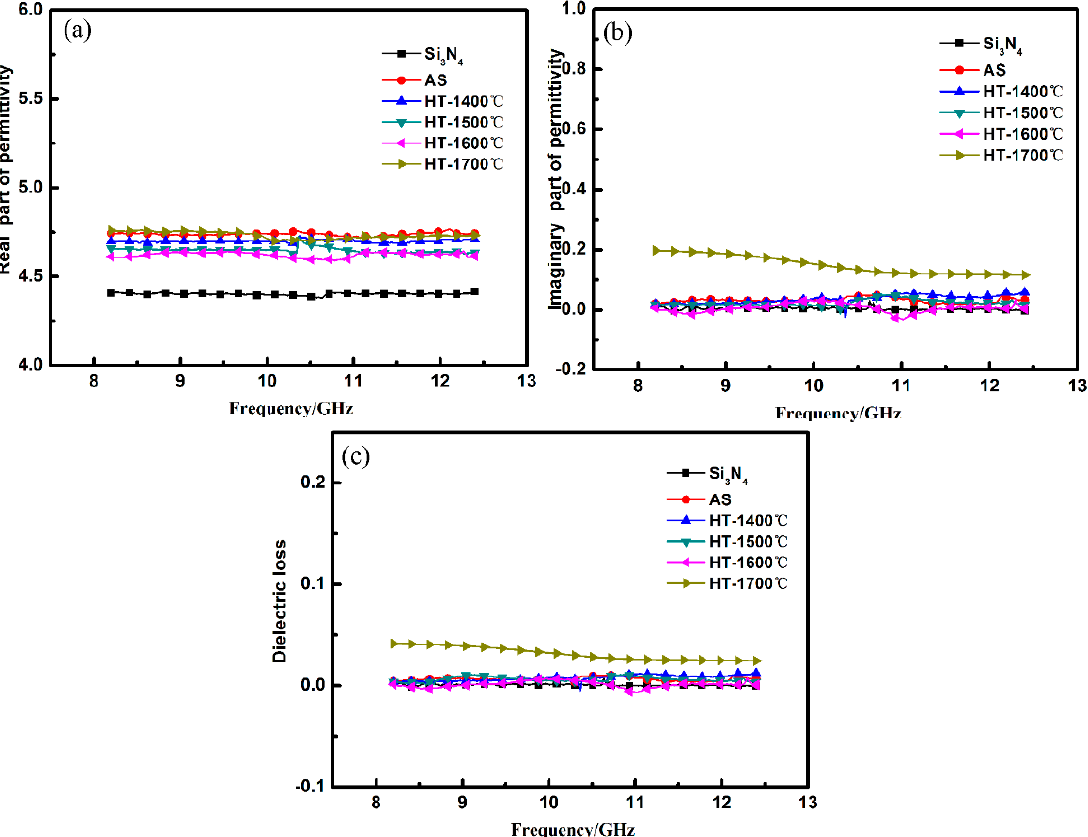
Figure 6. The permittivity of as-received and annealed SiBCN-Si 3 N 4 ceramics at different temperatures: ( a ) the real part; ( b ) the imaginary part; and ( c ) tangent loss.